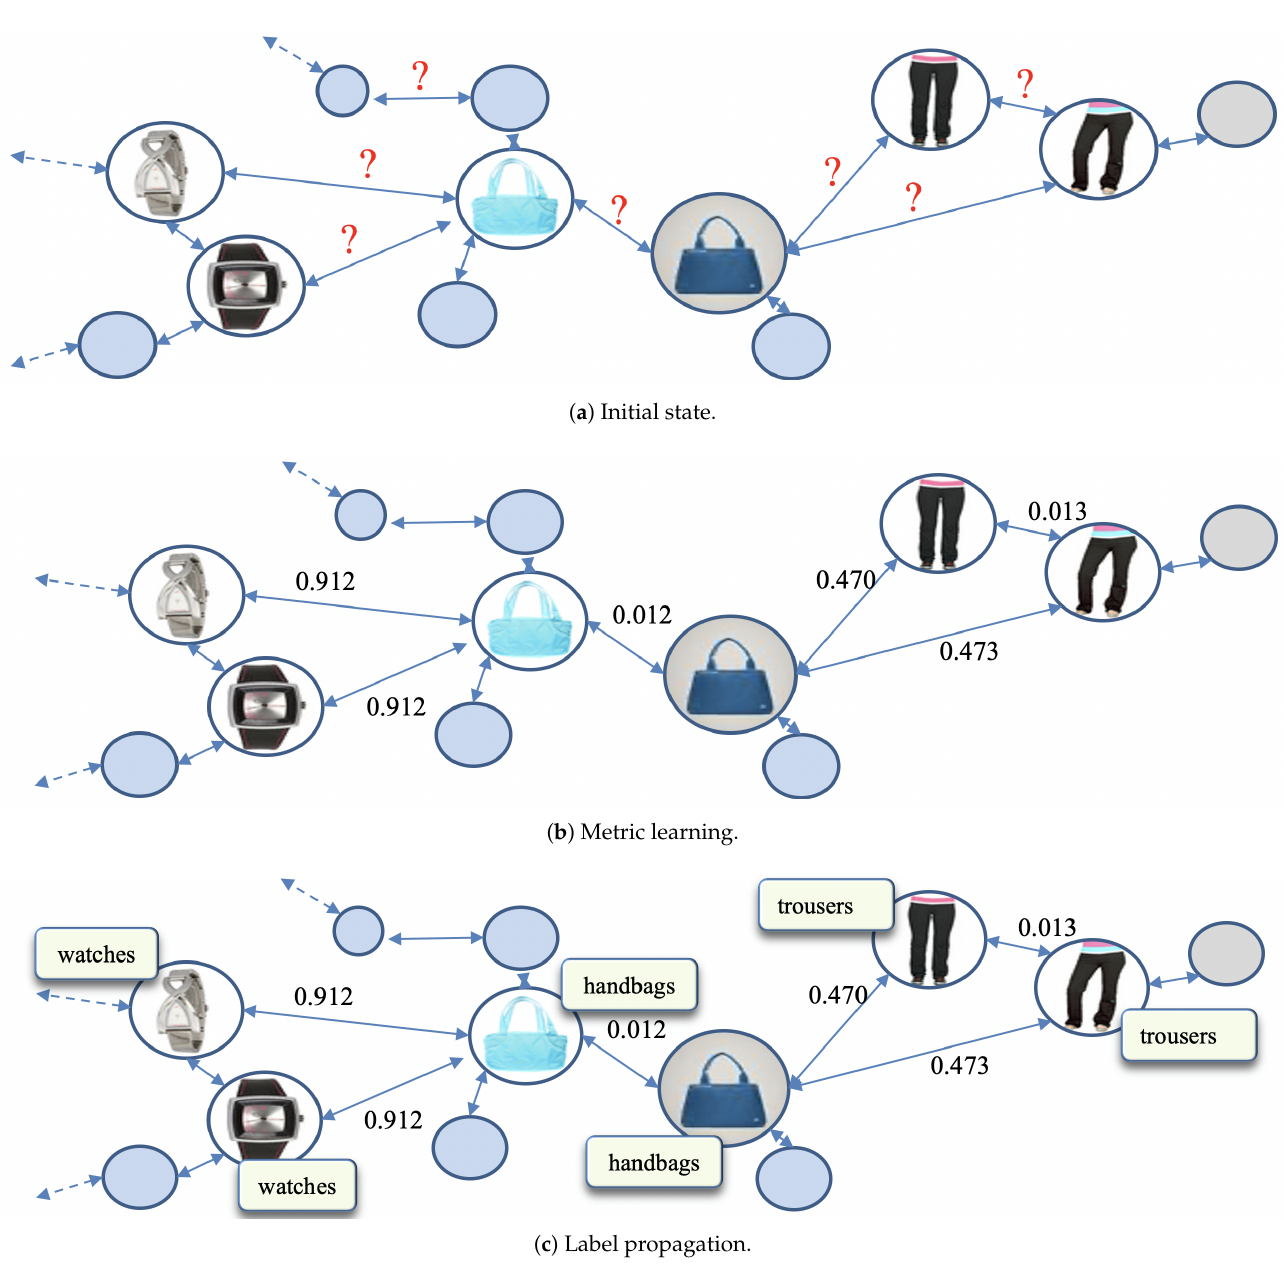
Figure 10. Step-by-step operations of proposed